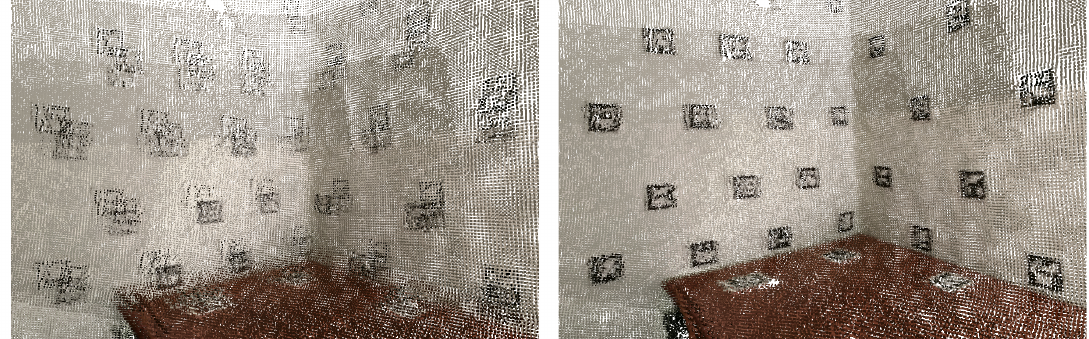
Figure 5. Merged point cloud coloured with texture obtained from images (detail): ( left ) before optimization; ( right ) after optimization.